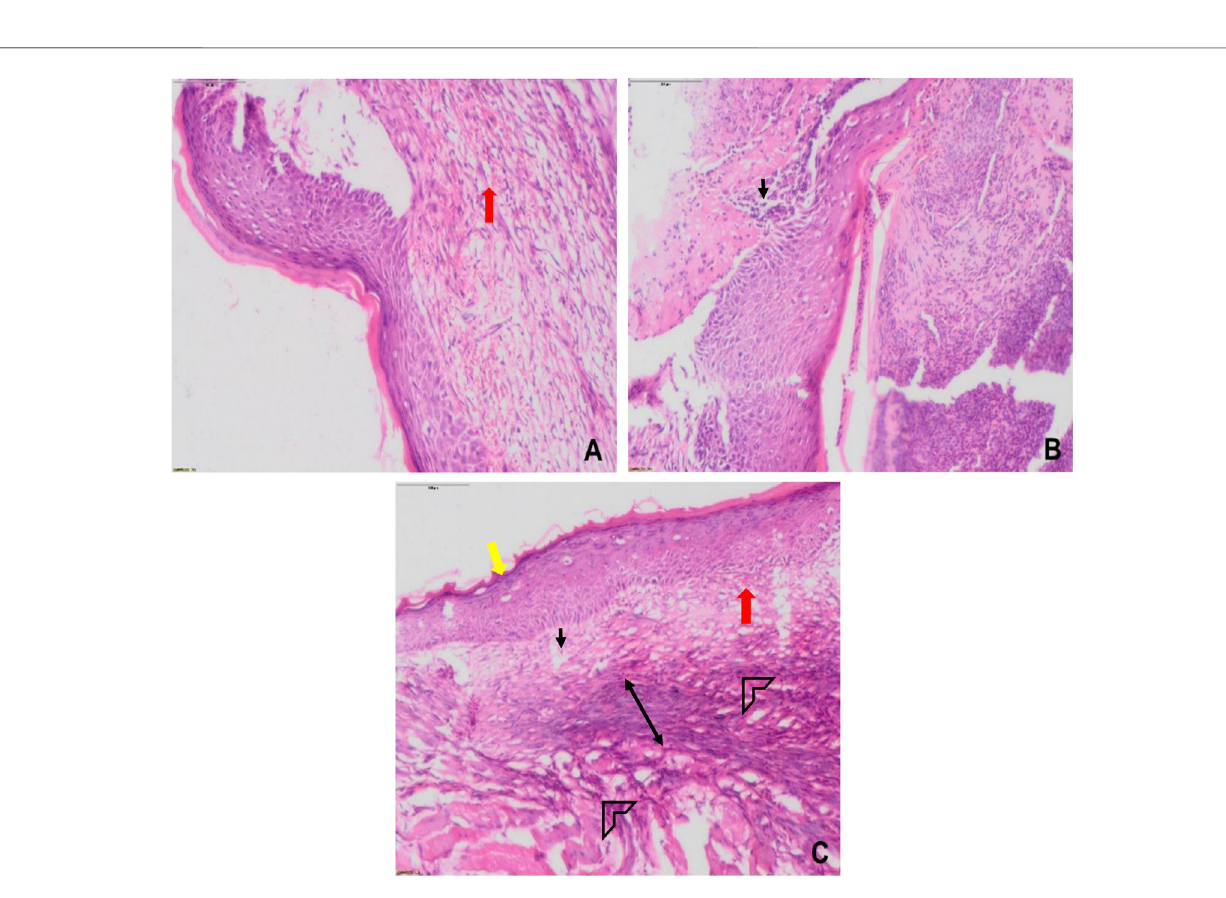
Frontiers in Pharmacology |